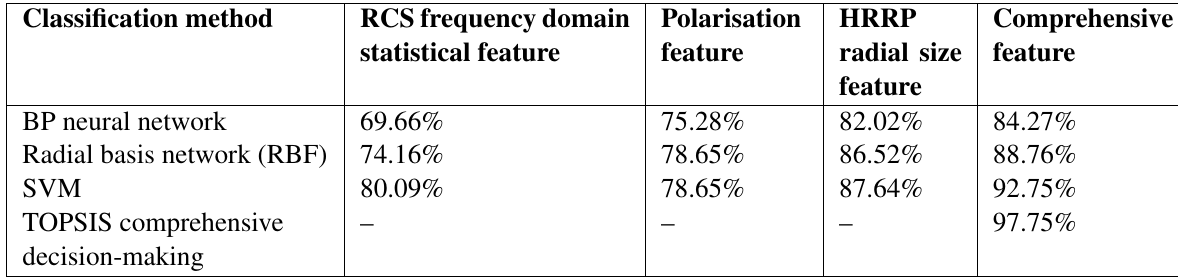
Table 3 The classification recognition